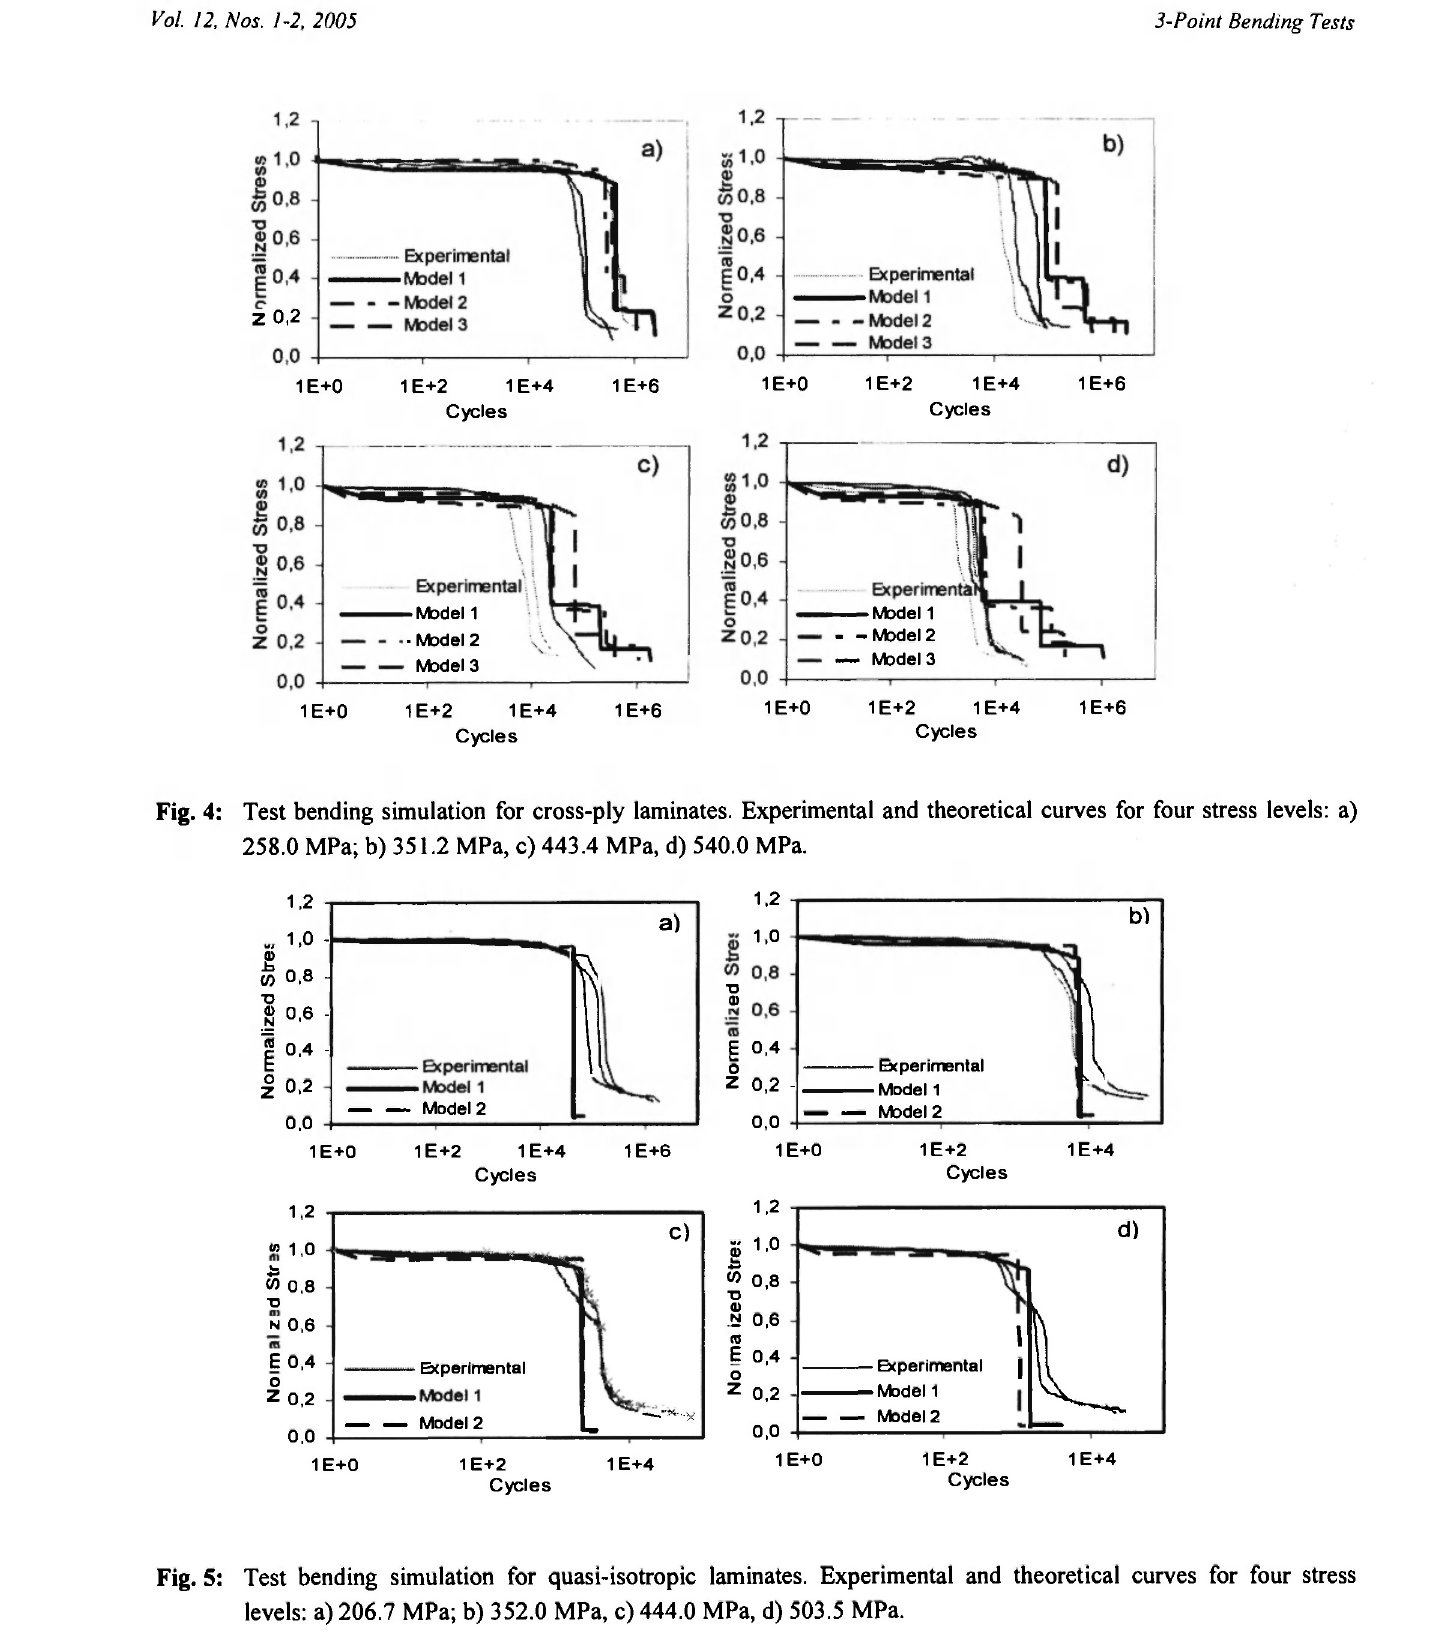
Fig. 5: Test bending simulation for quasi-isotropic laminates. Experimental and theoretical curves for four stress levels: a) 206.7 MPa; b) 352.0 MPa, c) 444.0 MPa, d) 503.5